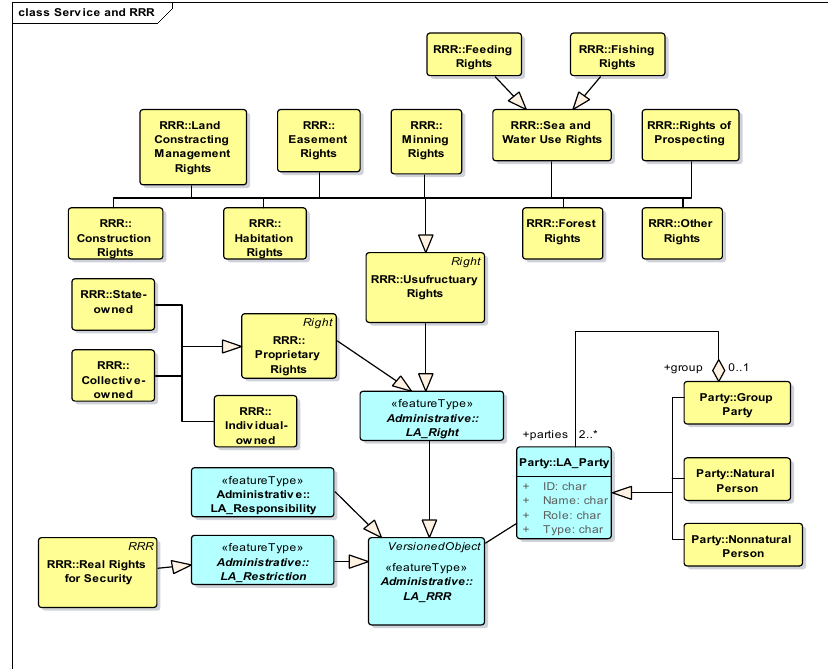
Figure 20. Party and RRR class.